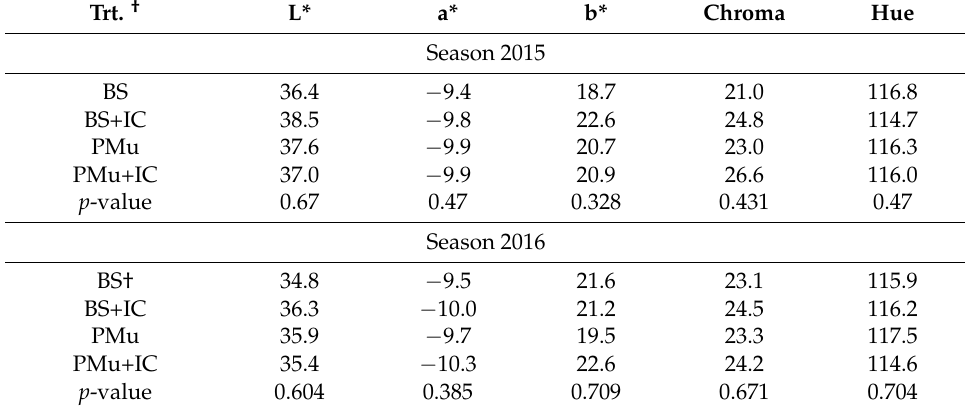
Table 2. Jalapeño pepper color variables (L*, a*, b*, Chroma, and Hue) as affected by mulching and intercropping, during two growing